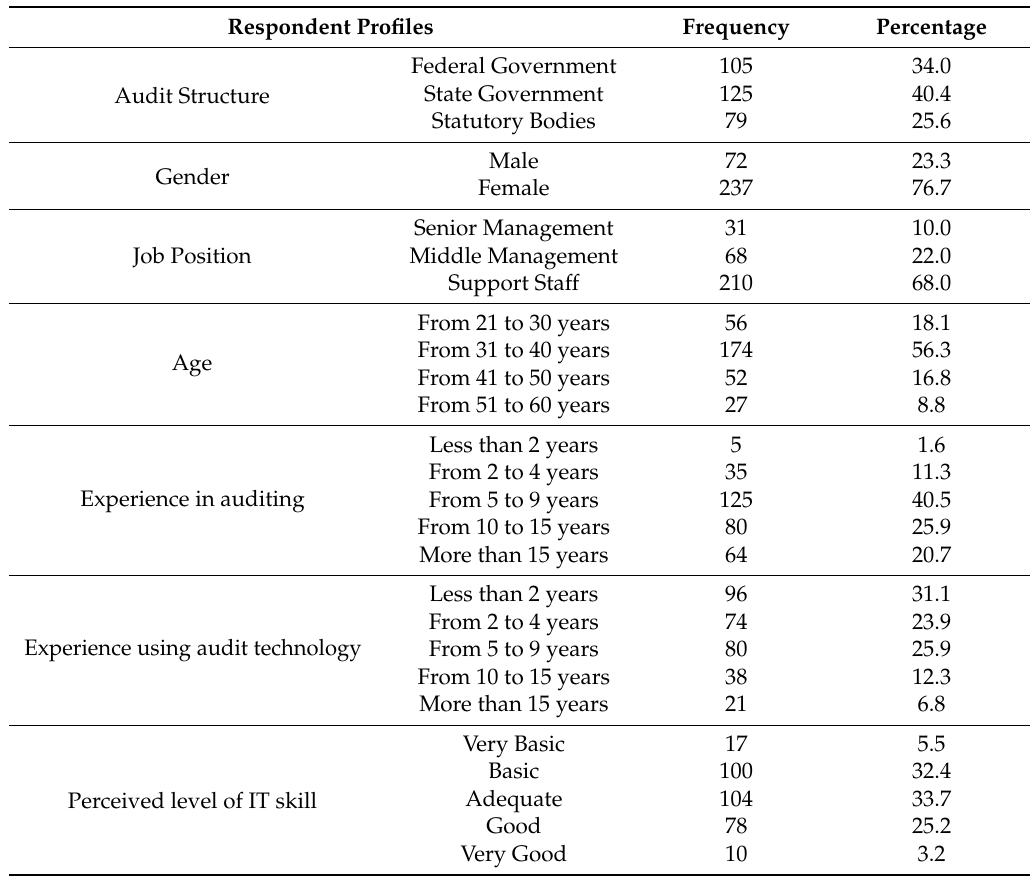
Table 2. Demographic profile ( N =